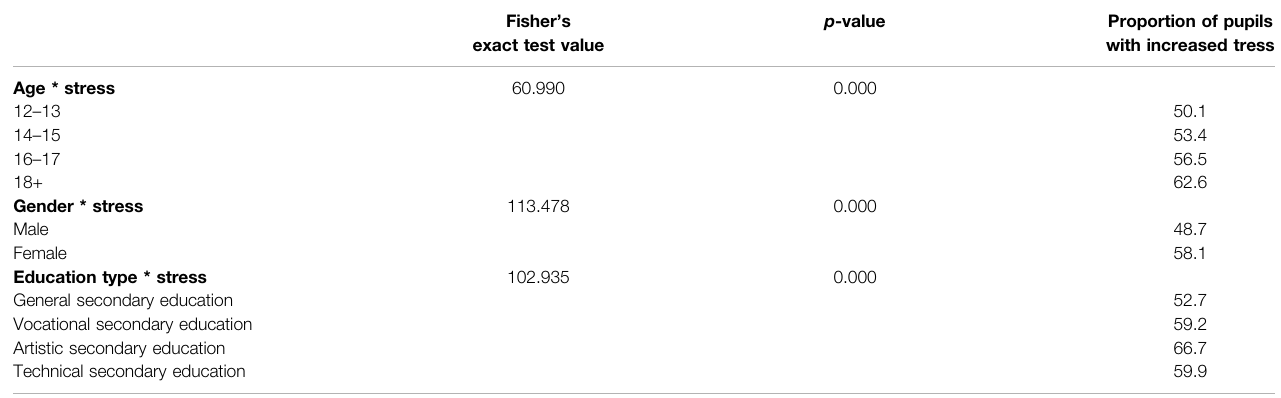
TABLE 3 | Fisher ’ s exact tests for associations between age, gender and education type, and increased stress.